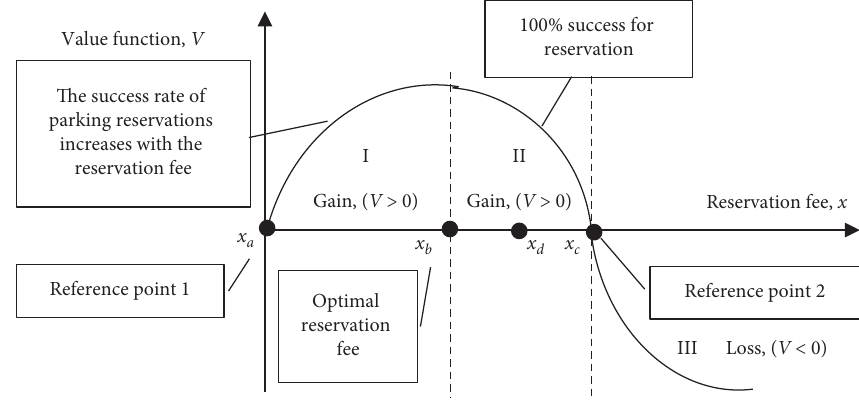
Figure 3: Value function of parking reservation fee